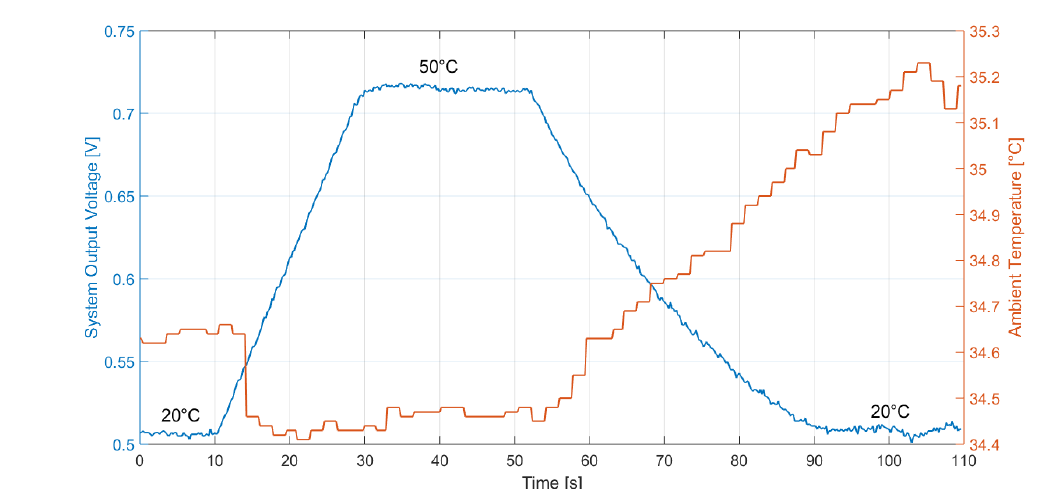
Figure 9. Measured thermopile sensor-interface circuit system output with the black body at 10-cm distance and the ambient temperature at 35 ◦ C. The black body temperature is varied in ramp fashion from 20 ◦ C to 50 ◦ C. The buffer offset was not subtracted from the output